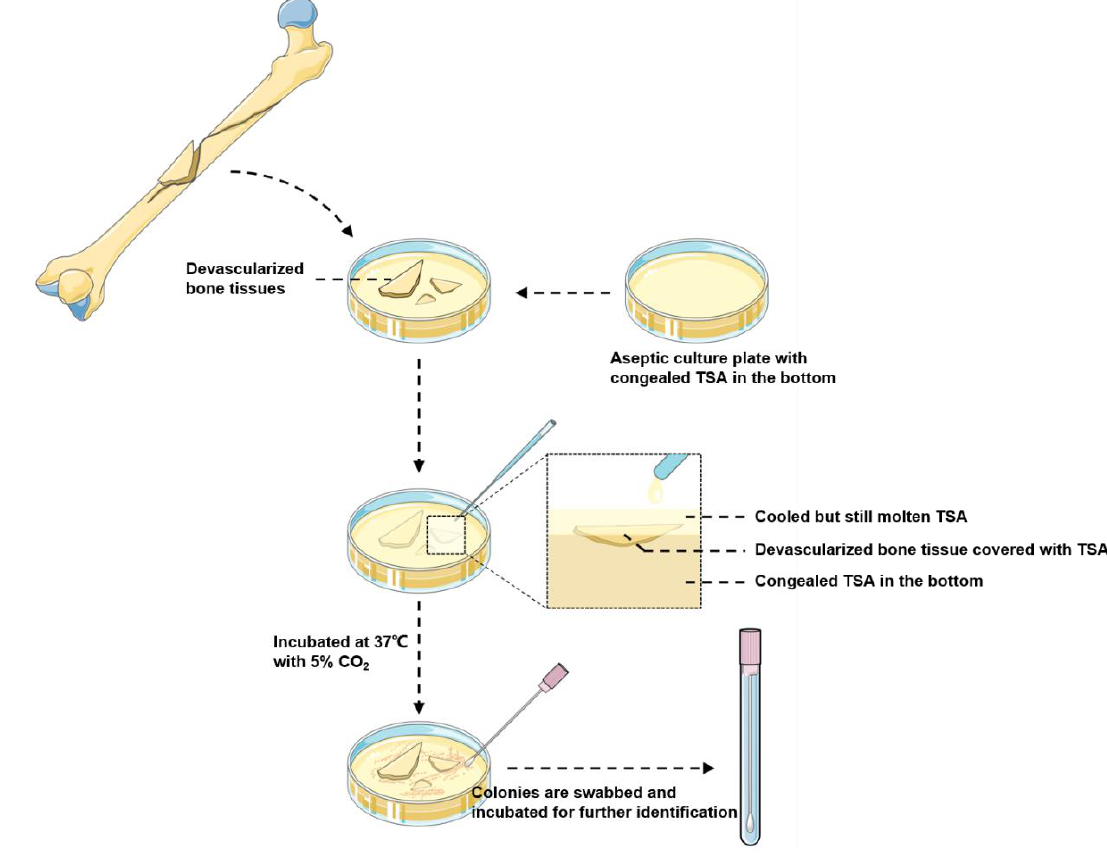
Figure 1. The schematic diagram of the BSC